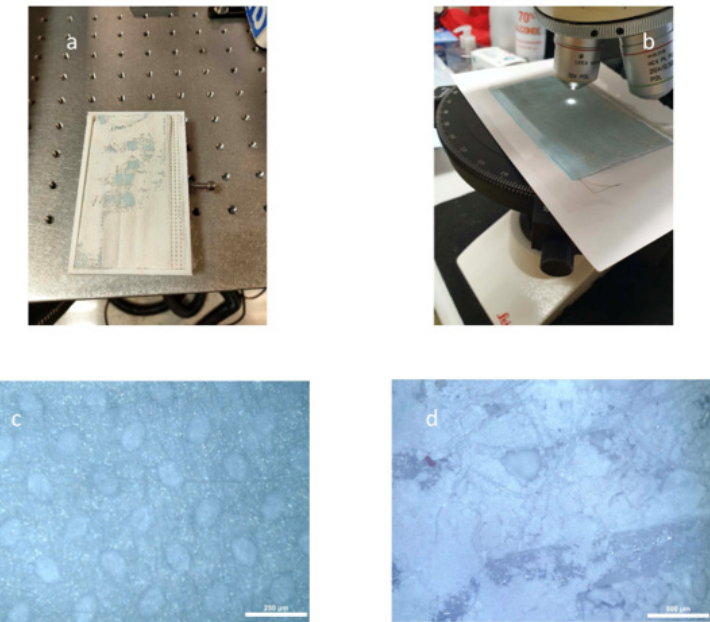
Figure 8. Study under the microscope of powder obtained after laser ablation. ( a ) Mask retrieved from the laser equipment; ( b ) mask under the microscope; ( c ) clean mask under the microscope — the original texture of the mask is shown here; ( d ) mask with the retained powder after laser abla ‐ tion — only a mass of talc is seen in this picture.